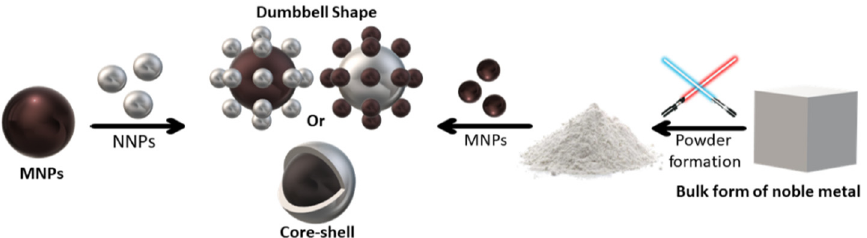
Figure 6. Noble metals–MNC synthesis. MNCs can be obtained by mixing two types of nanomaterials or by spraying noble metal powder on MNPs. Forms such as core–shell, dumbbell, flower, octahedral, star, rod, and Janus may be formed.